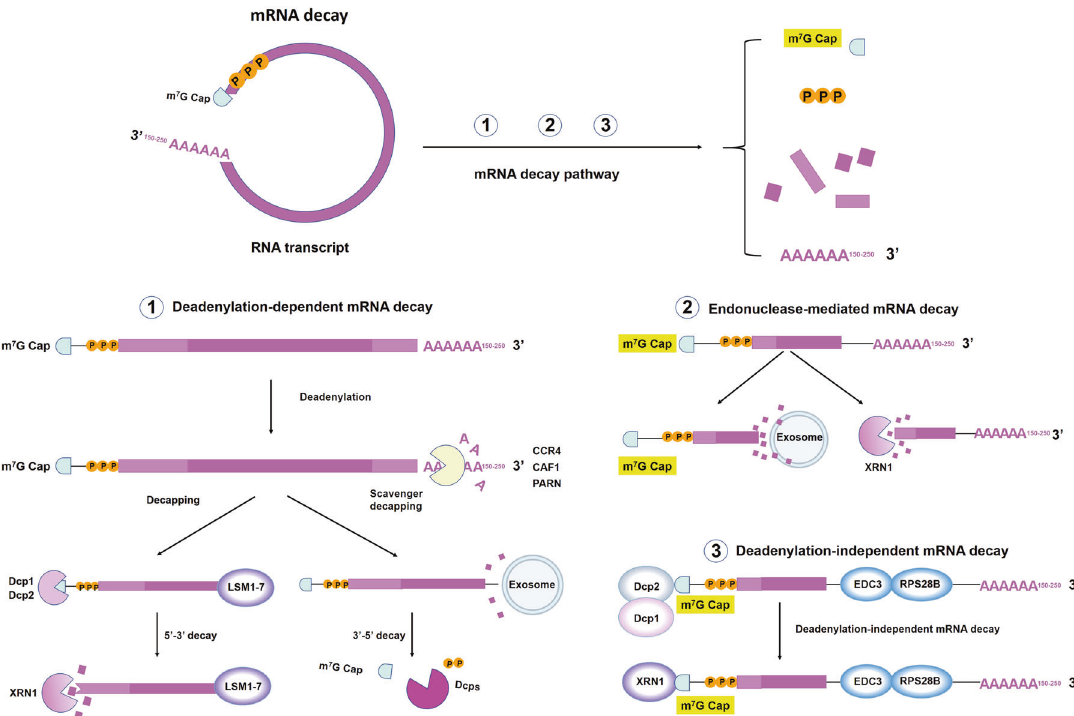
Fig. 4 Mechanisms of mRNA decay. Degradation of messenger mRNA plays an essential role in regulating sustained mRNA expression. mRNA is generally degraded in the following three pathways: ① Deadenylation-dependent mRNA decay: The poly(A) tail is removed by deadenylase activity (such as CCR4, CAF1 or PARN). The LSM1-7 complex associates with the 3 ′ -end of the mRNA transcript to induce decapping by the Dcp1 – Dcp2 complex and is then degraded by exoribonuclease XRN1. Alternatively, deadenylated mRNA can be degraded by exosomes. ② Endonuclease-mediated mRNA decay: The mRNA is cleaved into two fragments, and then the fragments are degraded by XRN1 and exosomes. 538 ③ Deadenylation-independent pathways require recruitment of the decapping machinery. RPS28B interacts with the enhancer of decapping-3 (Edc3) to engage the decapping enzyme. Subsequently, the mRNA is degraded by XRN1